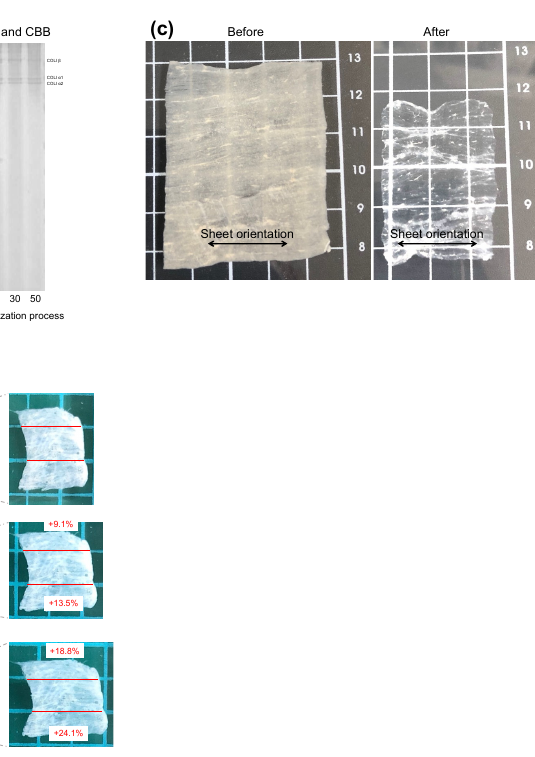
Figure 2. Preparation and properties of the decellularized skeletal muscle sheets. ( a ) Change in the amount of protein eluted by the decellularization solution; ( b ) Change in the remaining protein in the skeletal muscle sheet. The remaining protein was extracted and visualized by SDS-PAGE and CBB staining; ( c ) Appearance of the sheet before and after decellularization. The direction of the extracellular matrix remaining in the sheets can be visually confirmed; ( d ) DSMS attached to the chamber; ( e ) DSMS extension associated with manual stretching. CBB, Coomassie Brilliant Blue; DSMS, decellularized skeletal muscle sheets.